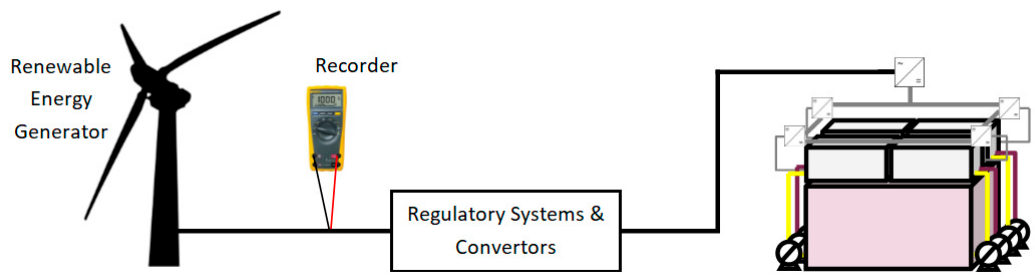
Figure 6. Placement of the data recorder on the AC line between the battery and power source.